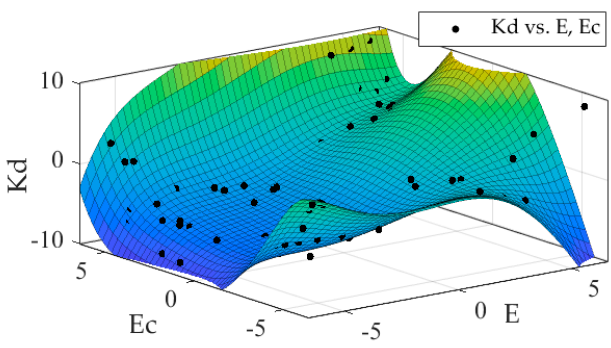
Figure 9. The fitting surface ∆ K i of the granular function.